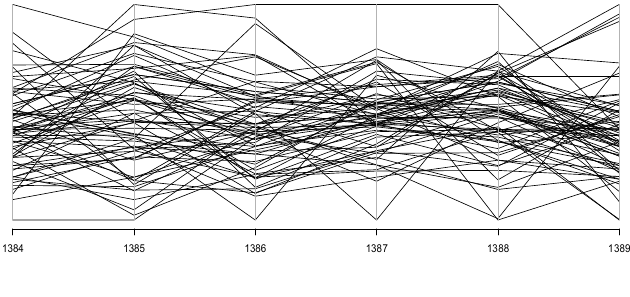
Fig. 3. Homogeneity of